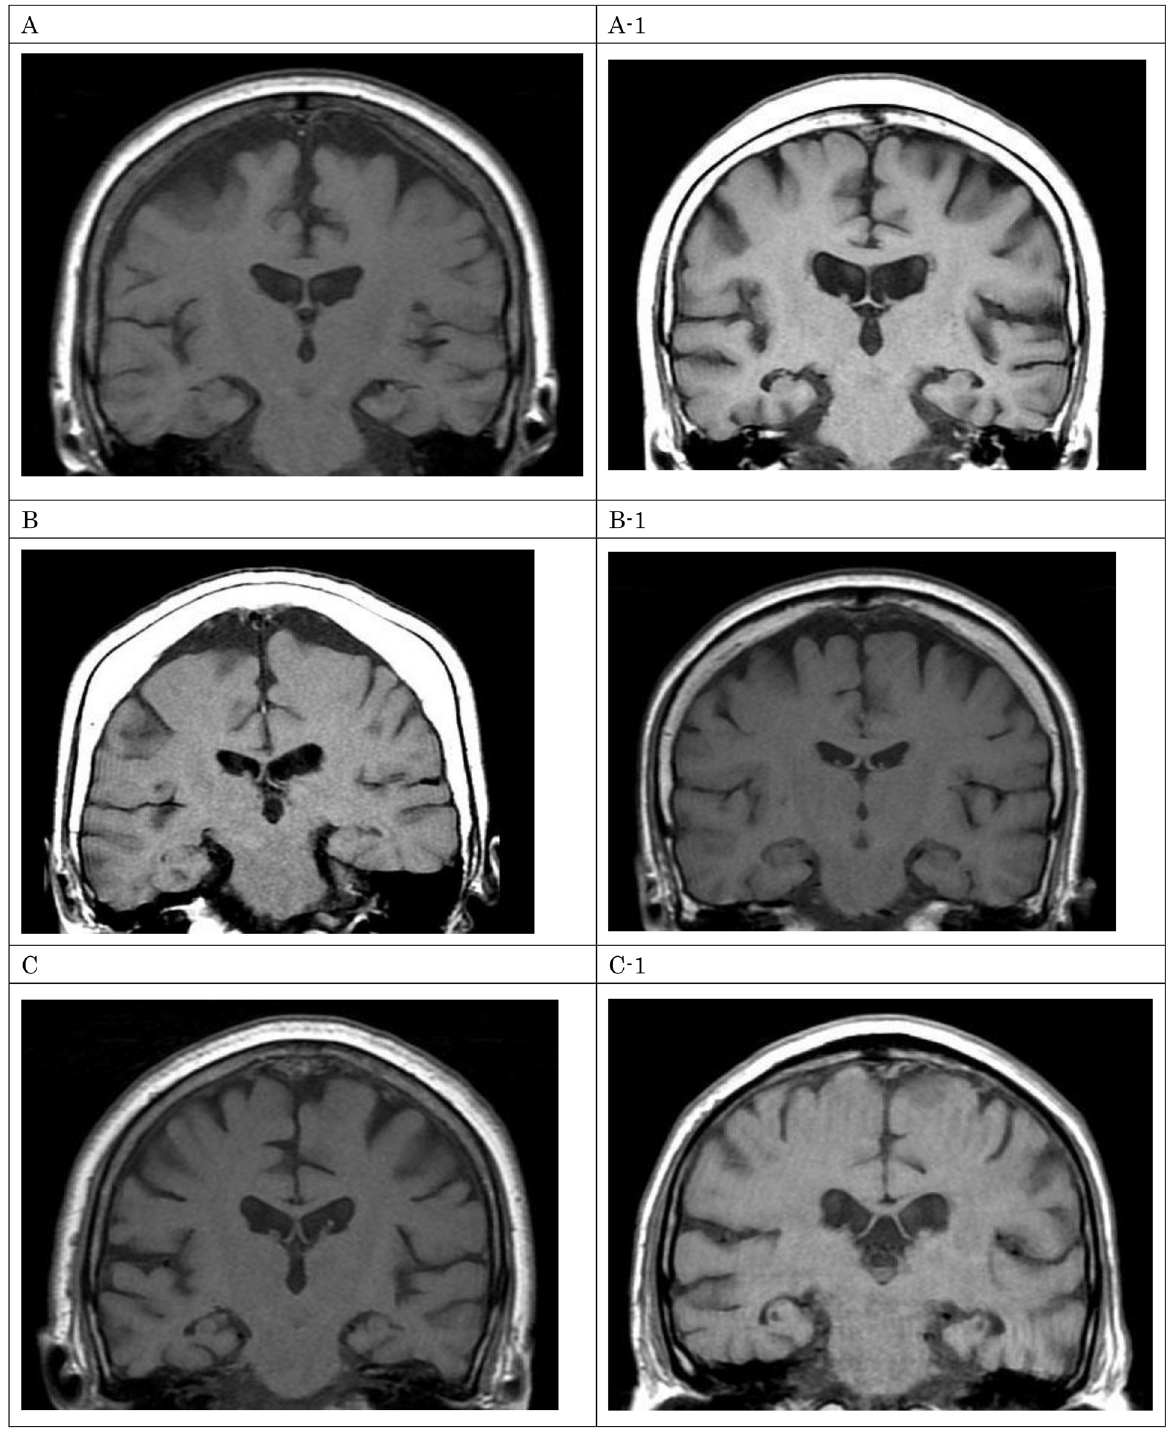
Fig 2. MRI of multilingual cases (A, B, C) and their controls (A-1, B-1, C-1), the degree of medial temporal lobe atrophy did not differ between the groups. The coronal views (perpendicular to the line intersecting the anterior and posterior commissures in the midsagittal plane) of the T1-weighted MRI image are illustrated in each